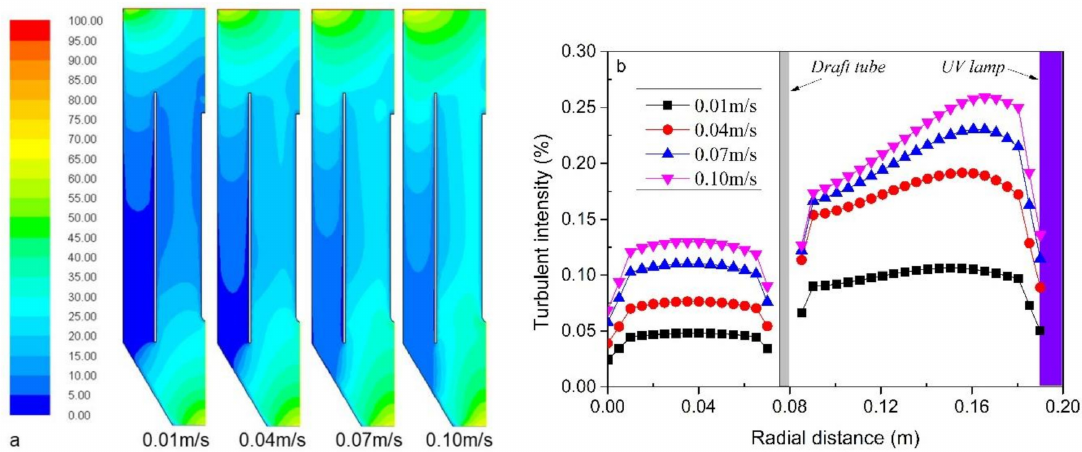
Figure 3. The contours ( a ) and the radial distribution ( b ) of turbulent intensity at di ff erent gas inlet velocities in Section